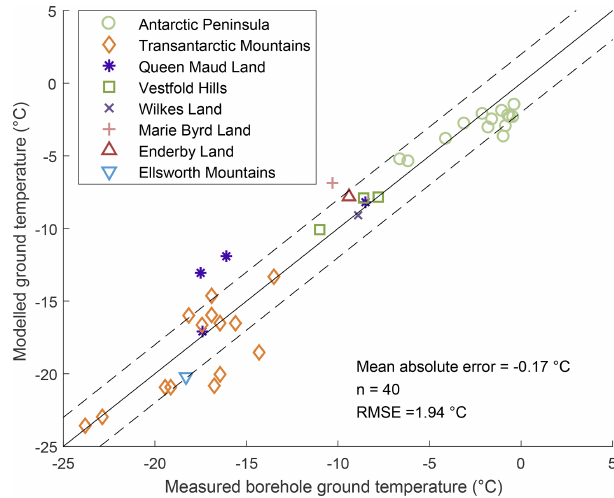
Figure 2. Measured vs. modelled permafrost temperatures for all boreholes. The dashed lines represent ± 2 ◦ C intervals around the 1:1 solid